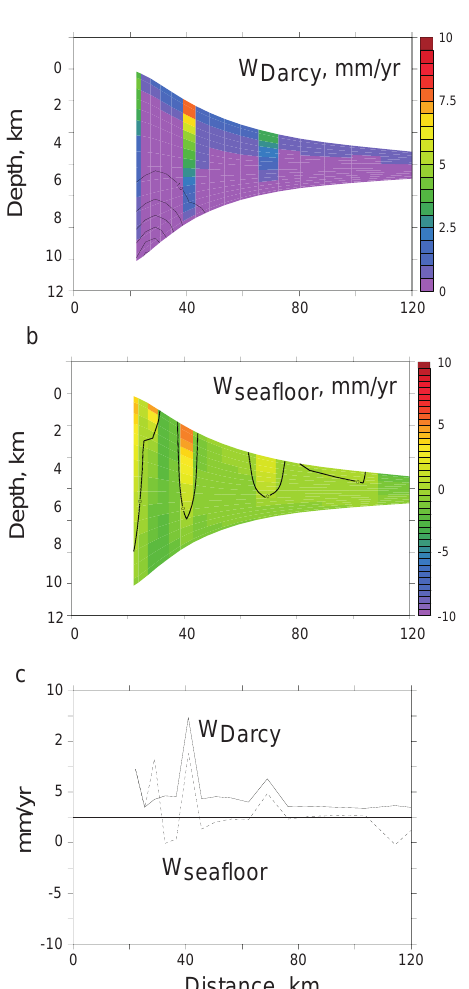
Fig. 6. (a) Sections of Darcy vertical velocities (flow relative to the grains), and (b) velocities relative to the sea floor, and (c) plots of w Darcy and w seafloor at the sea floor, for the Base sce- nario. Snapshots of other cases are shown in the Supplement files w darcy.pdf and w seafloor.pdf, and values at the sediment sur- face compared in w.pdf, and movies of w seafloor from the Base and Bumpy scenarios can be seen at http://geosci.uchicago.edu/ ∼ archer/ spongebob active/w darcy.active.movie.gif and velocities relative to the sea floor at http://geosci.uchicago.edu/ ∼ archer/spongebob active/w seafloor.active.movie.gif.